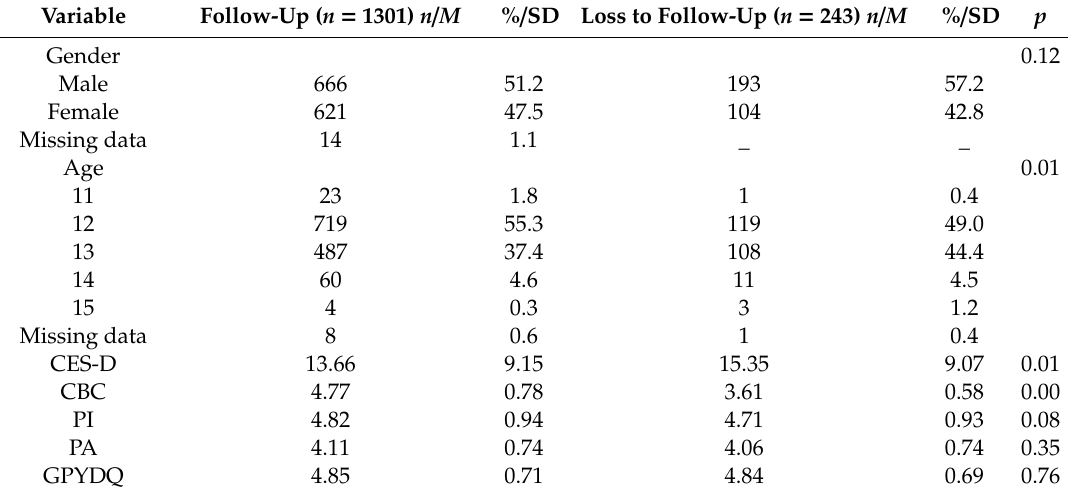
Table 2. Comparisons of PYD correlates and depressive symptoms of the participants measured at baseline by loss to